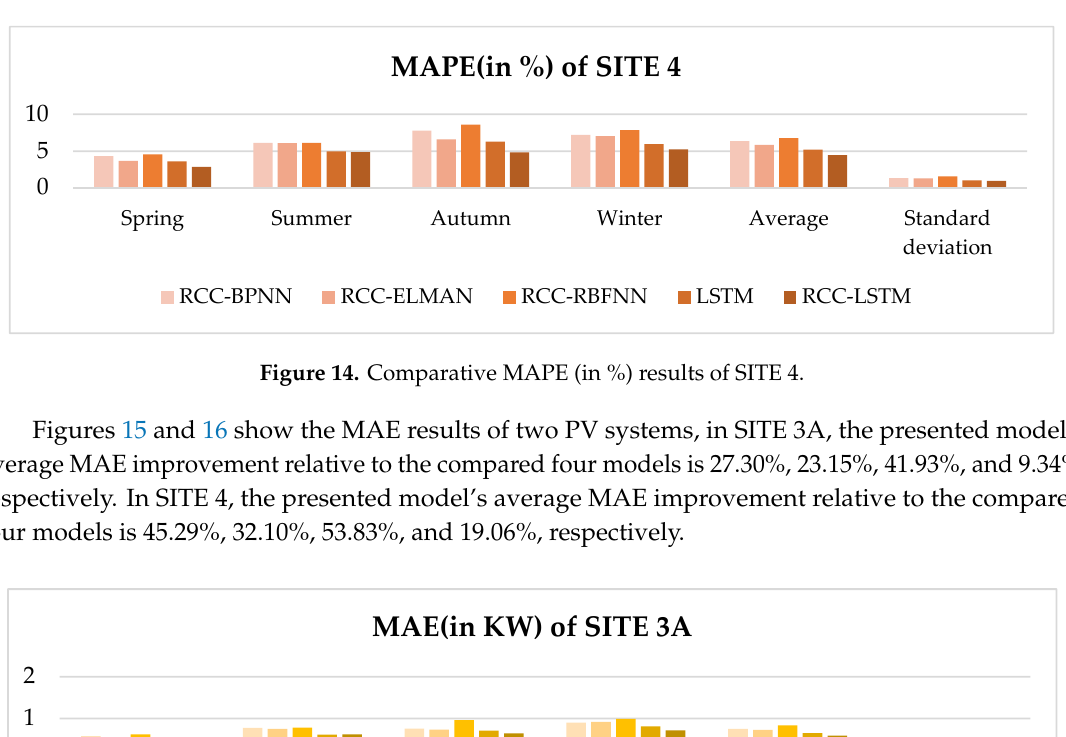
Figure 13. Comparative MAPE (in %) results of SITE 3A.